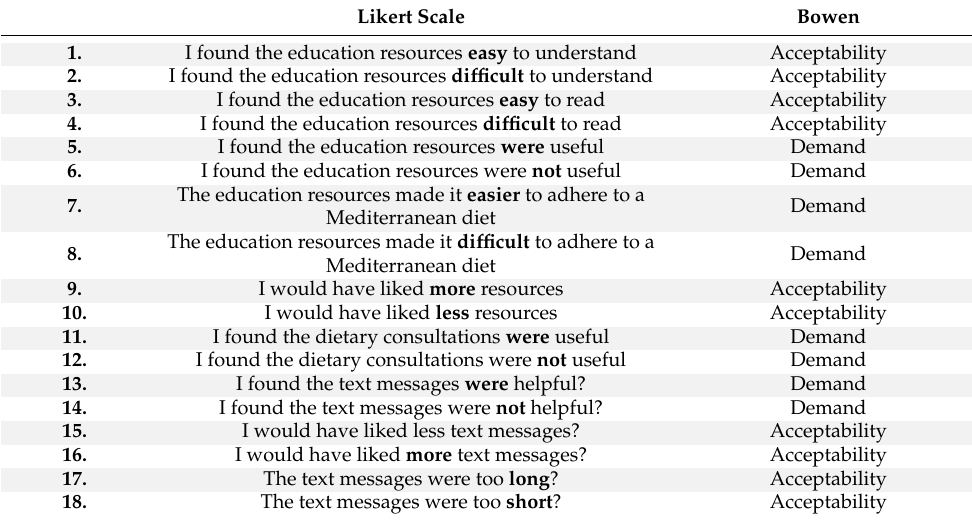
Table 7. Evaluation of intervention resources and program